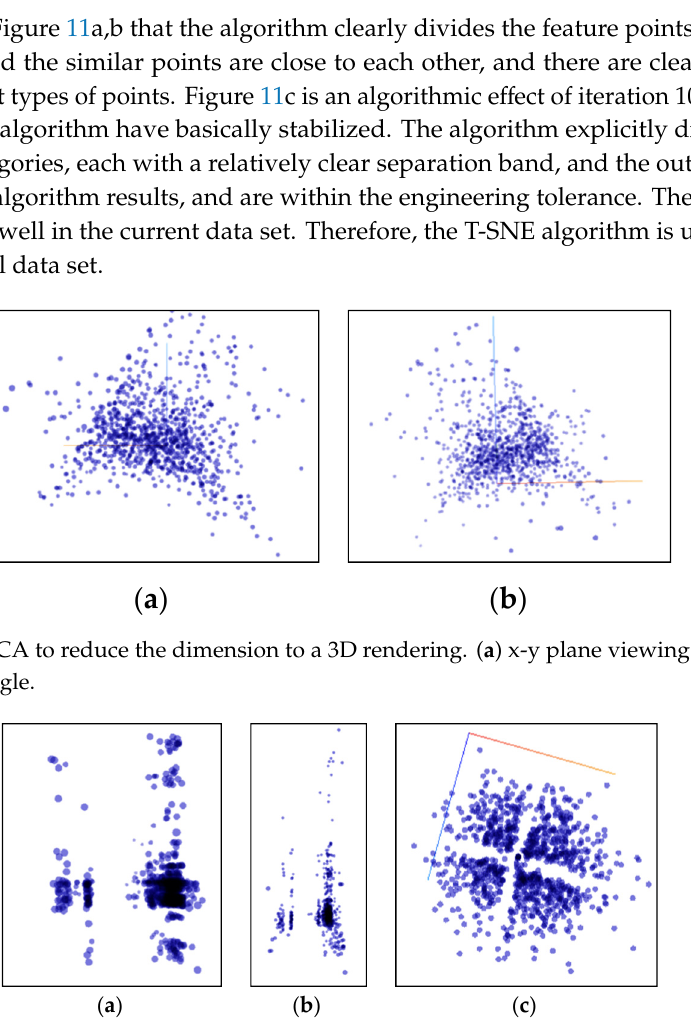
Figure 11. Use the T-SNE algorithm to reduce the dimensional effect. ( a ) Iteration 100 times; ( b ) Iteration 300 times; ( c ) Iteration 1000 times.